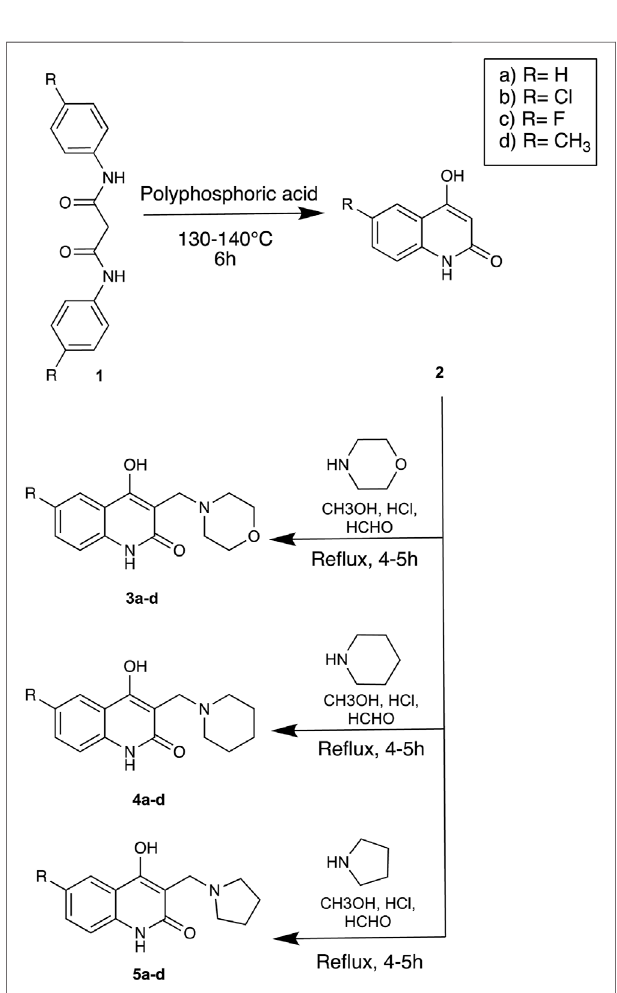
SCHEME 1 | Strategy for the synthesis of Linomide derivatives described in this paper.